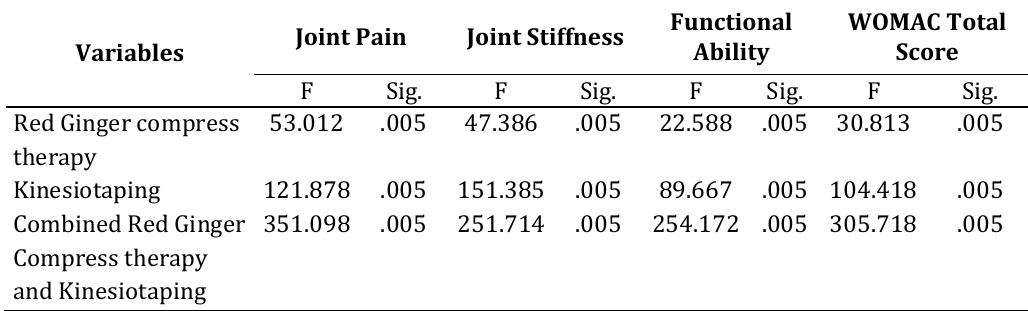
Multivariate analysis of independent variables towards joint pain, joint stiffness, functional abiltity and WOMAC total score